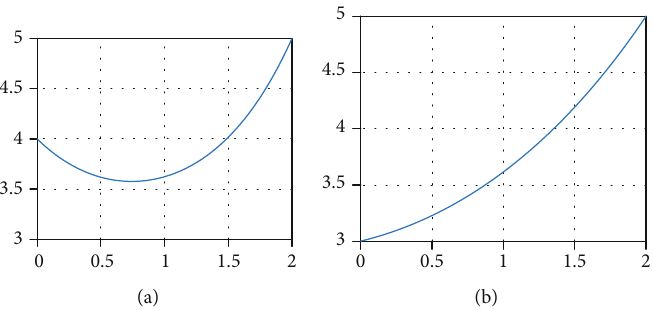
Figure 4: Di ff erent positions of vertex. (a) The vertex can be directly seen at a hanging rope with suspension points (0, 4) and (2, 5) and a length of 2.90 m. (b) The vertex can be positioned outside of the suspension points (b) with suspension points (0, 3) and (2, 5) and a length of